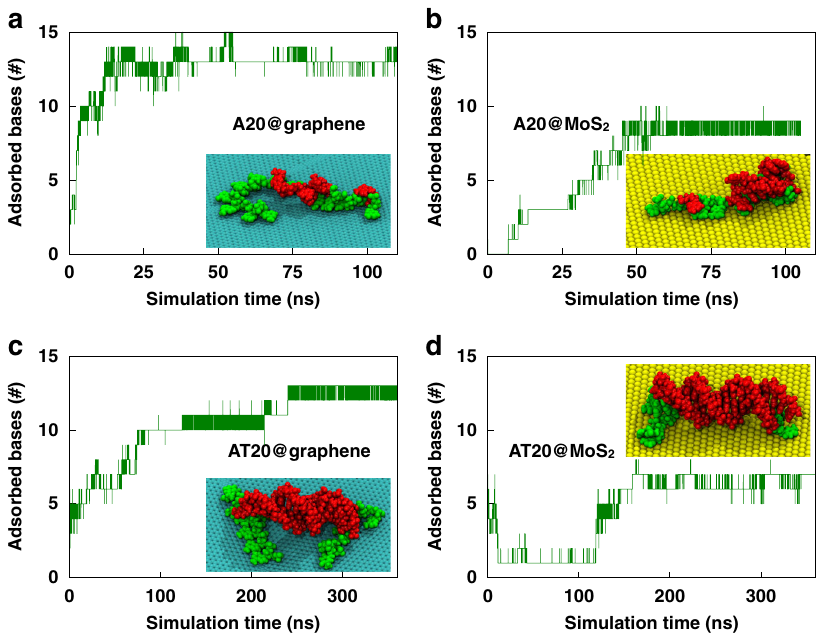
Fig. 3 Comparison of DNA adsorption on graphene and MoS 2 membranes. Top : Number of DNA bases adsorbed on a graphene a and MoS 2 b membrane in simulations where an ssDNA A20 was initially placed 1 Å above the membrane. Bottom : same as top but for a dsDNA AT20. In the case of the dsDNA on a MoS 2 membrane, a fi ctive mathematical boundary mimicking a wall parallel to the MoS 2 layer and locating 2.6 nm above the membrane was applied in the simulation; without such a wall, the complex may diffuse quickly into the bulk once the simulation is